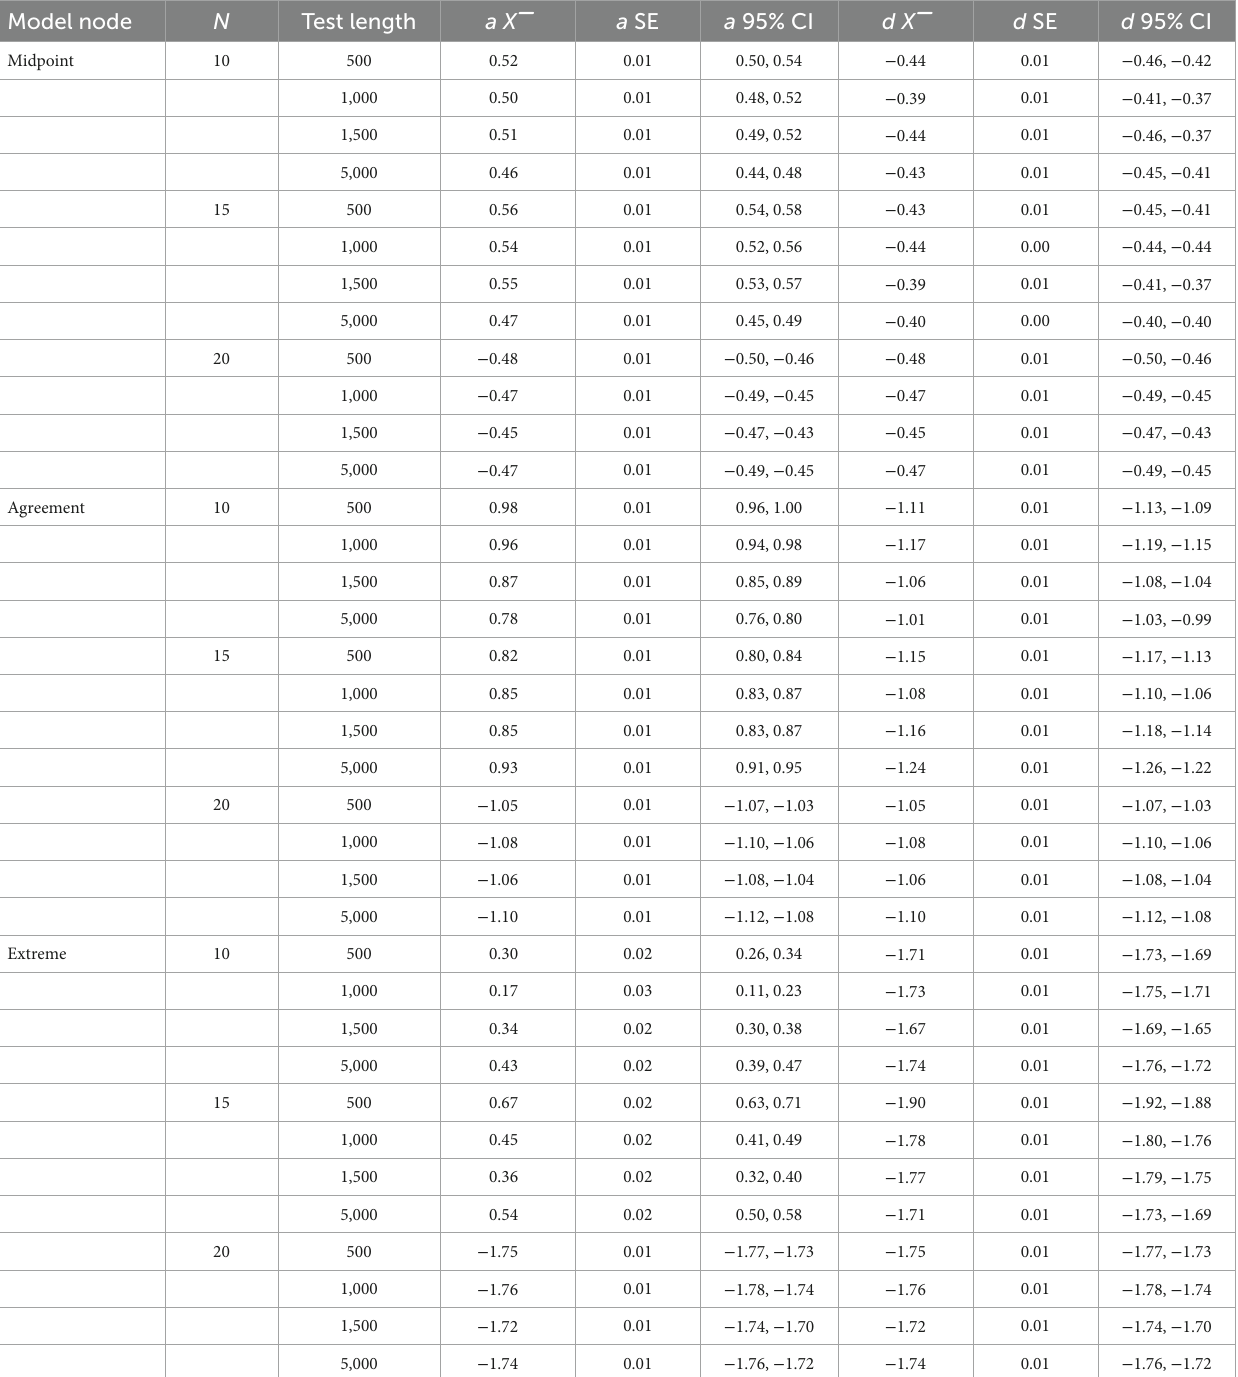
TABLE 4 Parameter recovery statistics for the IRTree MPP model fitted to IRTree MPP model data. Model